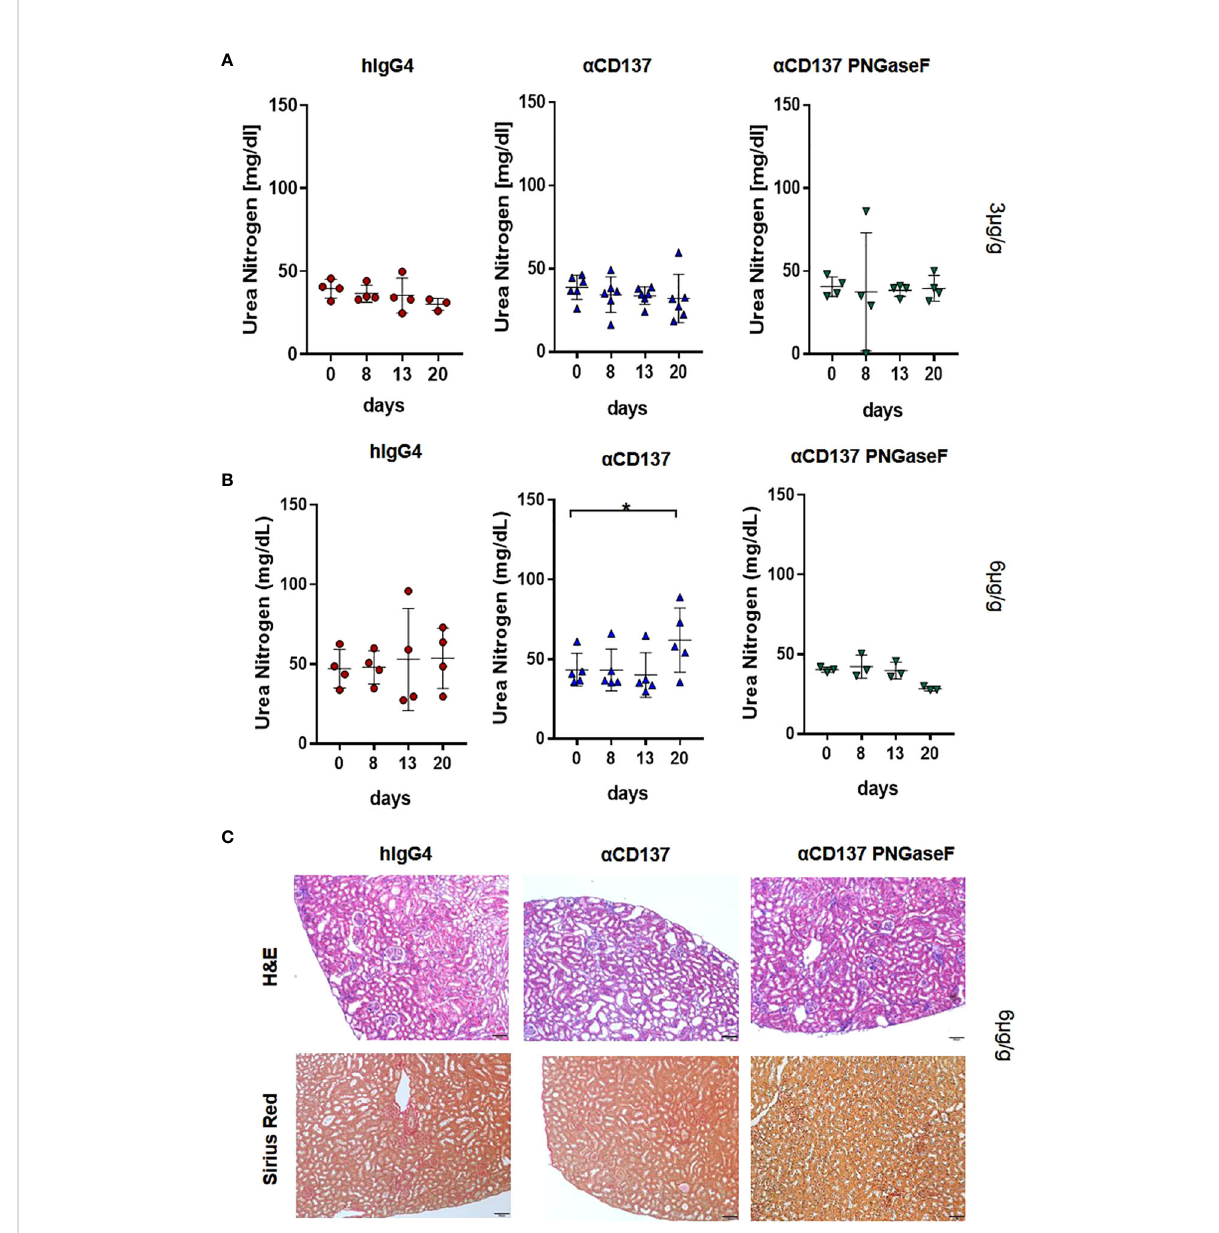
FIGURE 6 Impact of a CD137 treatment on kidney function. Humanized mice received either 3 or 6µg/g of a human IgG4 isotype control, urelumab ( a CD137) or deglycosylated urelumab ( a CD137 PNGaseF). (A, B) Shown are blood urea nitrogen (BUN) levels before (day 0) or at the indicated timepoints after treatment of humanized mice with 3 (hIgG4: n=4, a CD137: n=6, a CD137 PNGaseF: n=4) (A) or 6 (hIgG4: n=4, a CD137: n=5, a CD137 PNGaseF: n=3) (B) µg/g of the IgG4 antibody variants, as indicated. (C) Shown are hematoxylin-eosin (H – E) and Sirius red stainings of kidney sections of mice treated with 6µg/g of the indicated IgG4 antibody variants twenty days after antibody injection. Scale bars represent 100µm. Results are expressed as mean with SD. Statistical analysis was done by using Shapiro-Wilk normality test; p values were determined by using either Friedman test with Dunn ’ s multiple comparison analysis or One-Way-Anova with Tukey ’ s multiple comparison test.